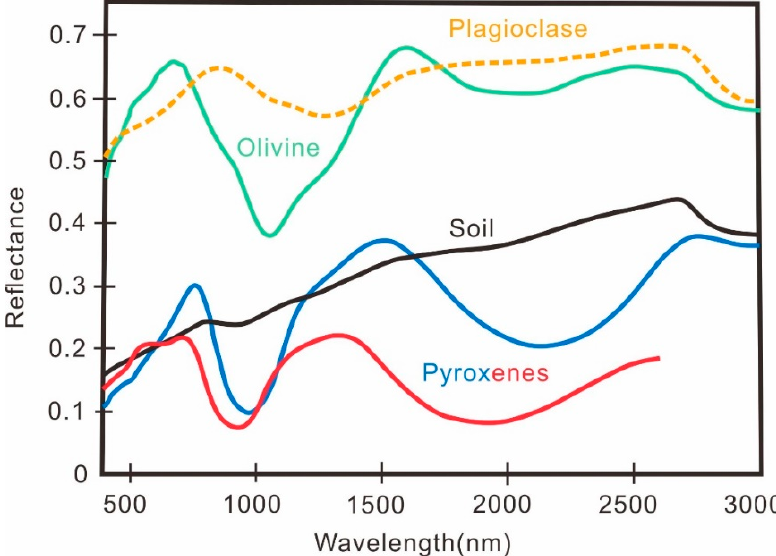
Figure 3. Laboratory reflectance spectra of representative lunar minerals and regolith of M3 data (modified from Pieters et al. [30]).